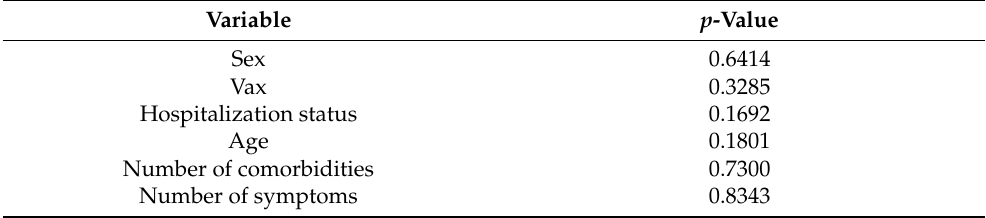
Table 1. p -values of the comparison (Fisher’s exact test) between the Delta and Omicron